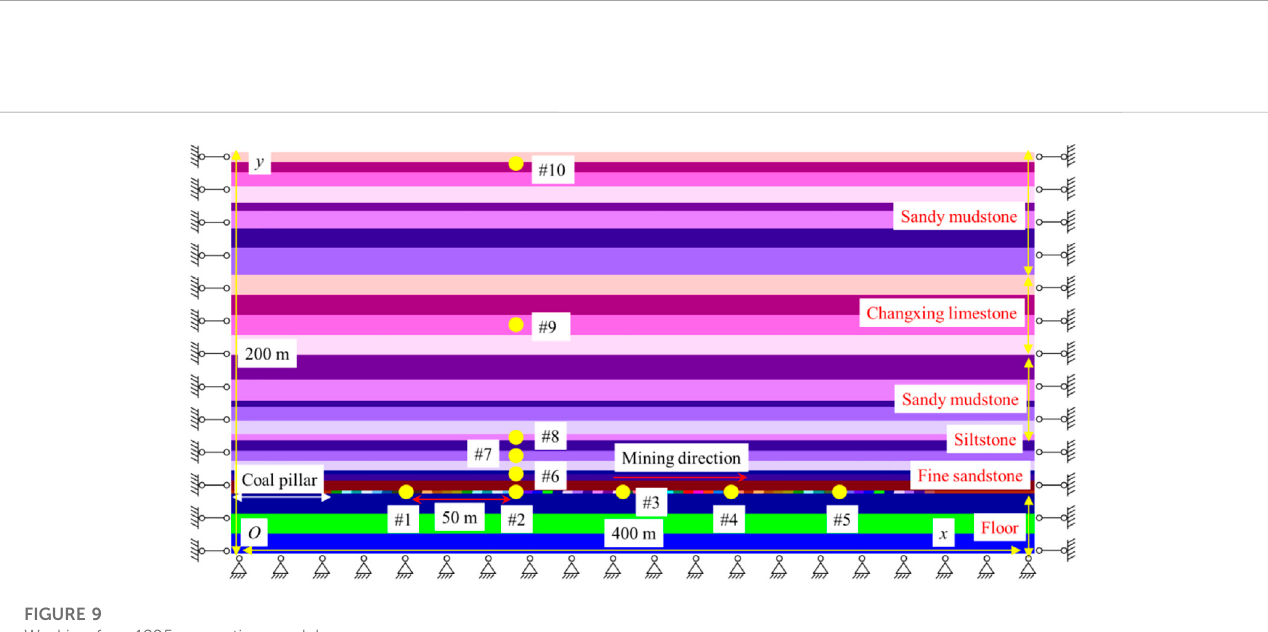
FIGURE 9 Working face 1295 excavation